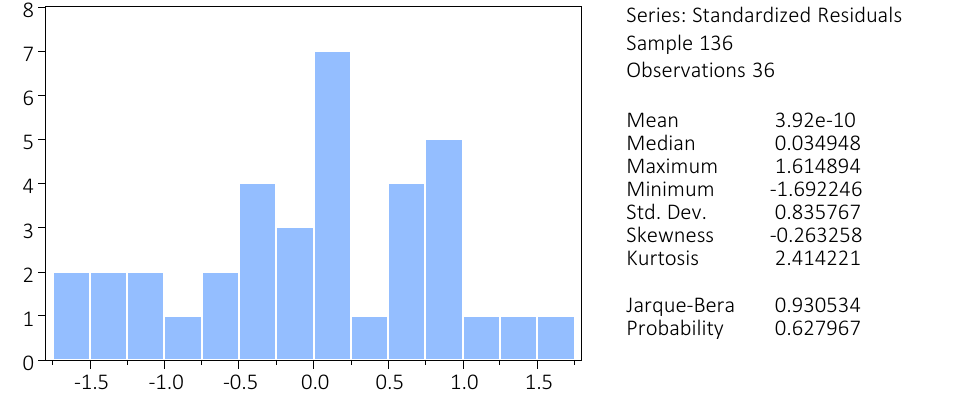
Figure 1. The normality test result on